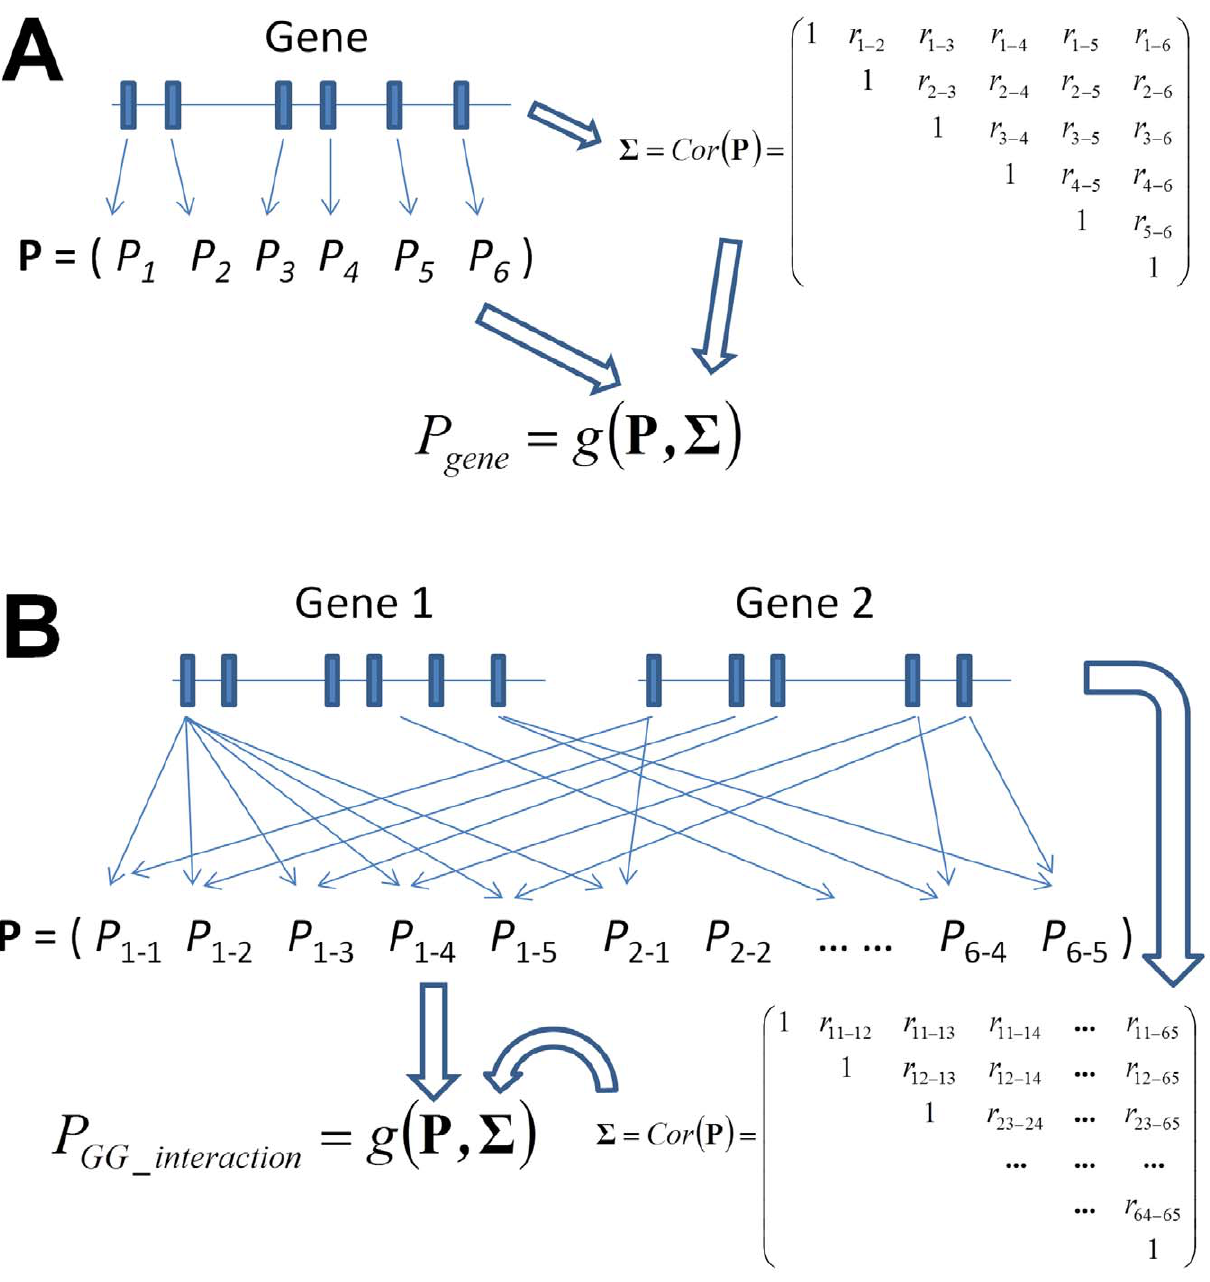
Figure 1. Graphical illustration of the framework of gene-based single-marker test and its generalization to a gene-based gene– gene interaction (GGG) test as proposed in this paper. While the former considers the P values of each single-marker test (A), a GGG test (B) is based on all P values of an interaction test between each pair of markers from each of the two genes. In order to combine these pairwise P values into a single test, a correlation matrix that concurrently accounts for linkage disequilibrium in each of the two genes needs to be estimated, which we derive in Materials and Methods.